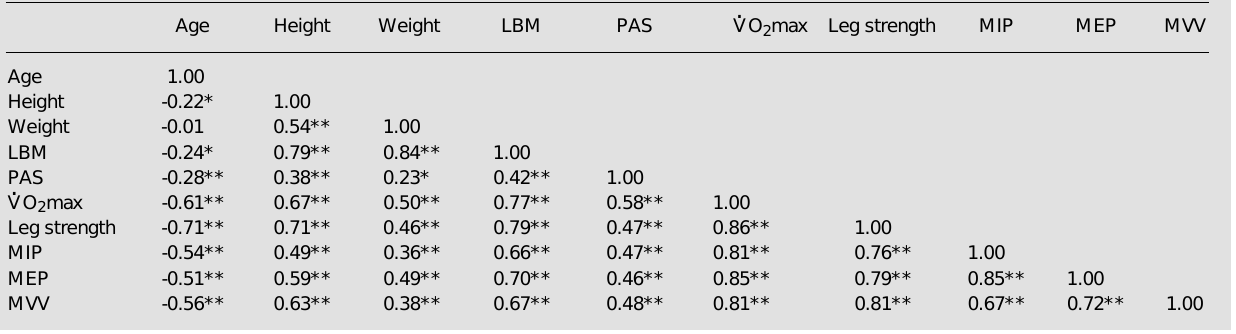
Table 2 - Correlation matrix.